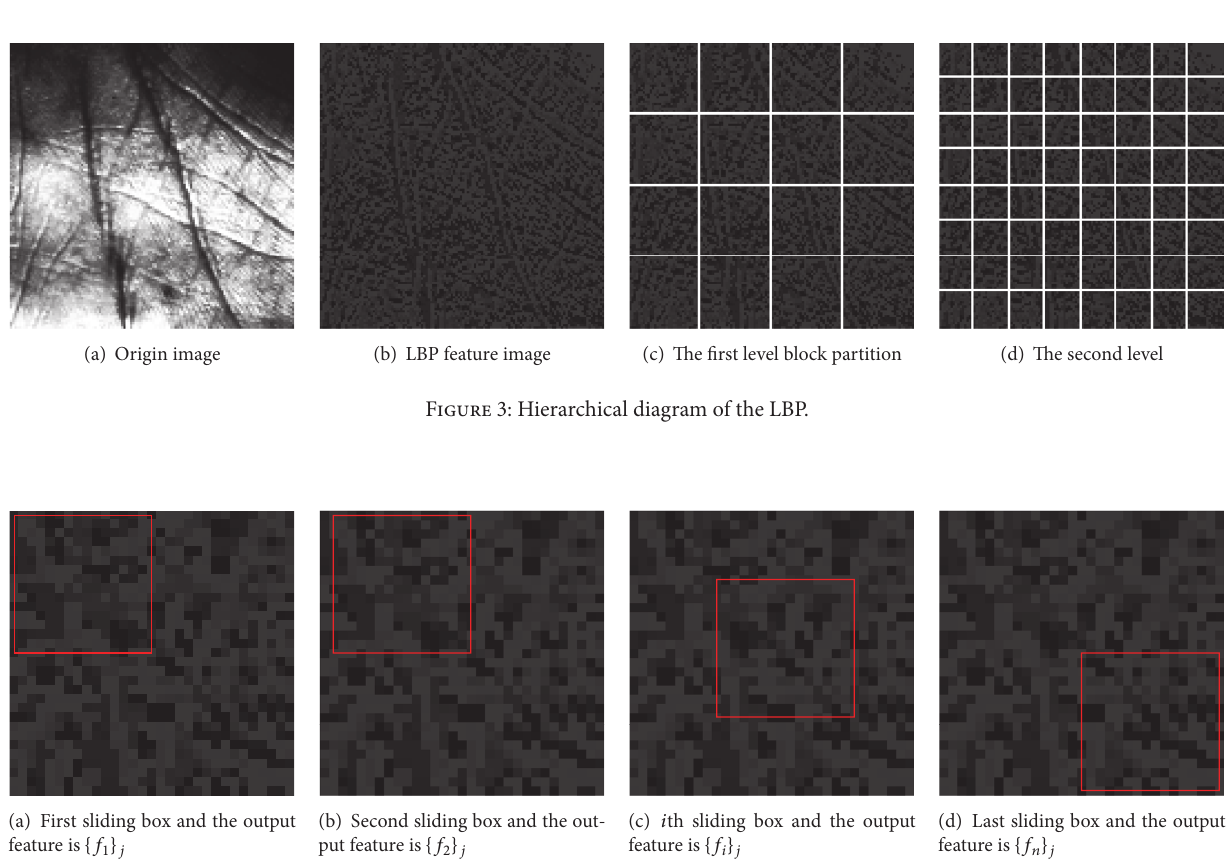
Figure 4: Illustration of the feature generation in the 𝑗 th